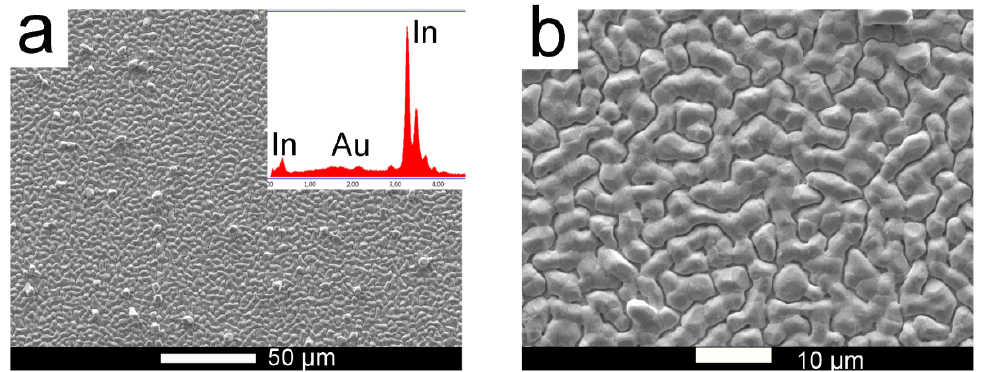
Figure 2. Scanning electron microscopy (SEM) images of indium deposits at low ( a ) and high ( b ) magnifications obtained after electrodeposition at − 2.2 V for 2 h.